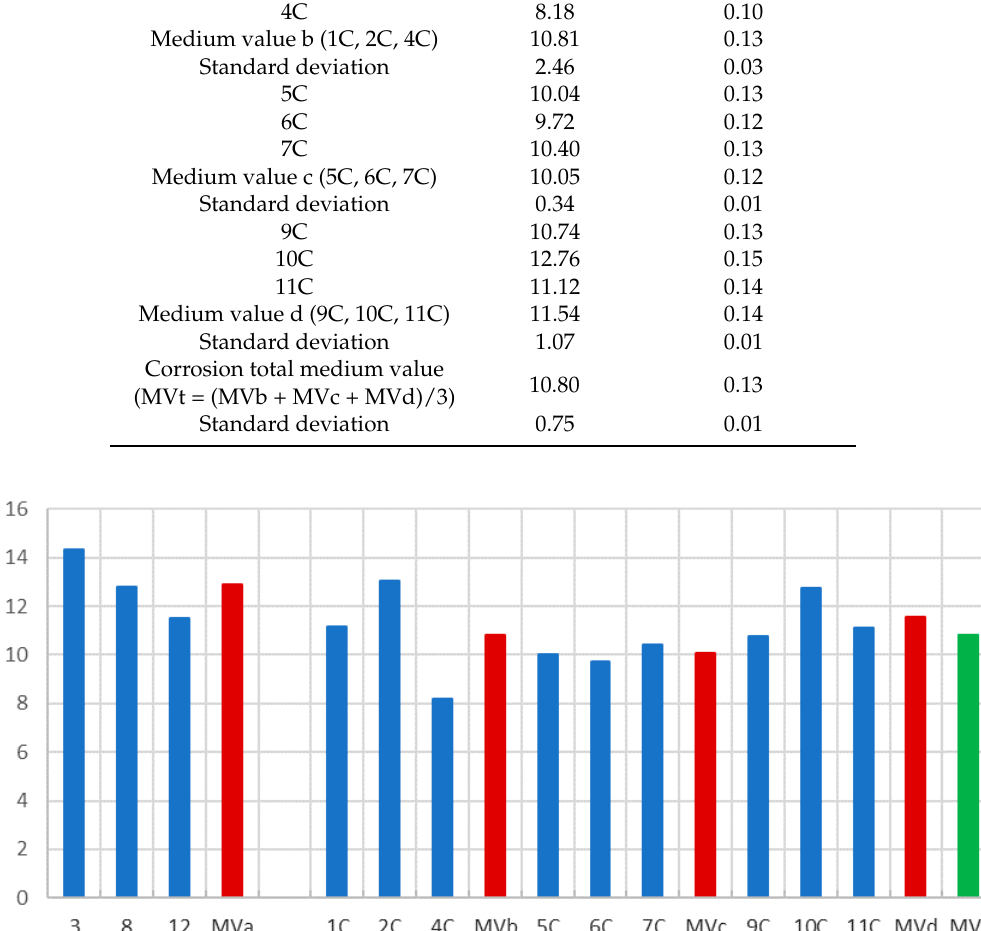
Table 6. Elongation at break and elongation at break/section relation values per specimen and medium values.